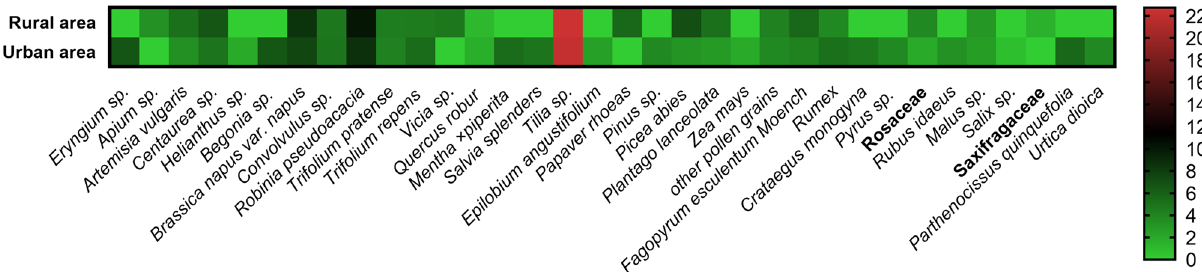
Figure 1. Pollen types obtained from the honey samples and their frequency. Heatmap of the mean frequency of pollens in honey samples from urban and rural areas.